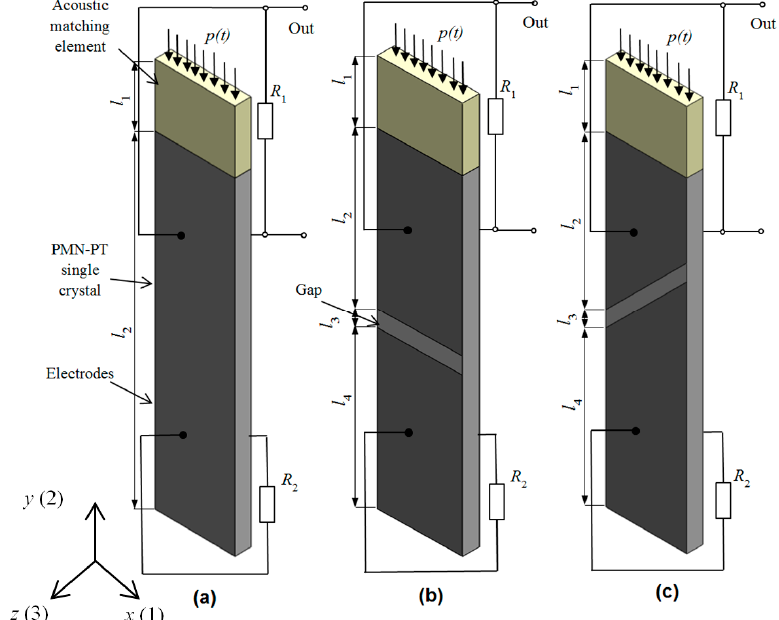
Figure 1. Piezoelectric strip-like receivers operating in a transverse-extension mode: ( a )—with continuous electrodes; ( b )—with two rectangular electrodes—case A; ( c )—with two non-rectangular electrodes—case B; p(t) is the incident acoustic pressure.